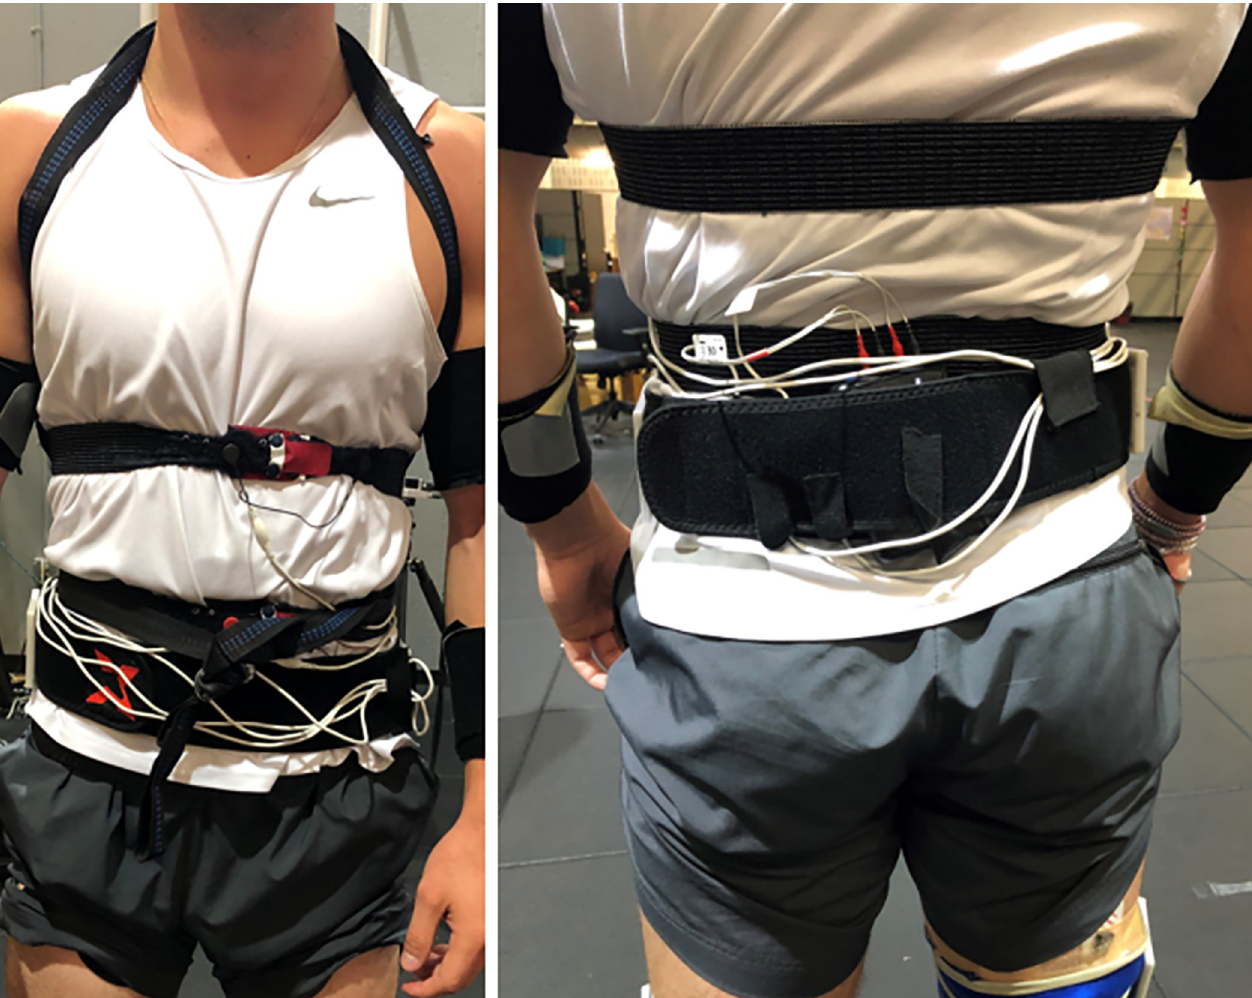
Fig 4. Equipment worn by participants. Anterior and posterior view of the equipment worn by participants while running. This equipment included two RIP belts, a heart rate monitor, a harness, and a neoprene belt. The neoprene belt housed the BioRadio, which was used to detect changes in voltage outputs of the belts, and additionally was where excess wiring from the RIP belts to the BioRadio was held